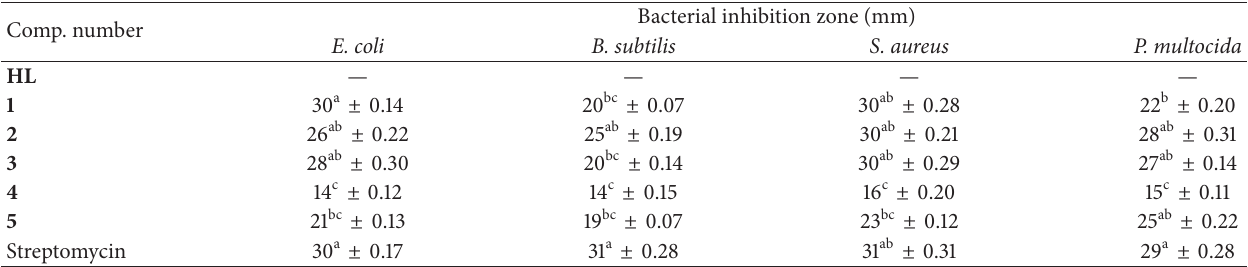
Table 10: Antibacterial activity data a,b of organotin complexes 1–5 .